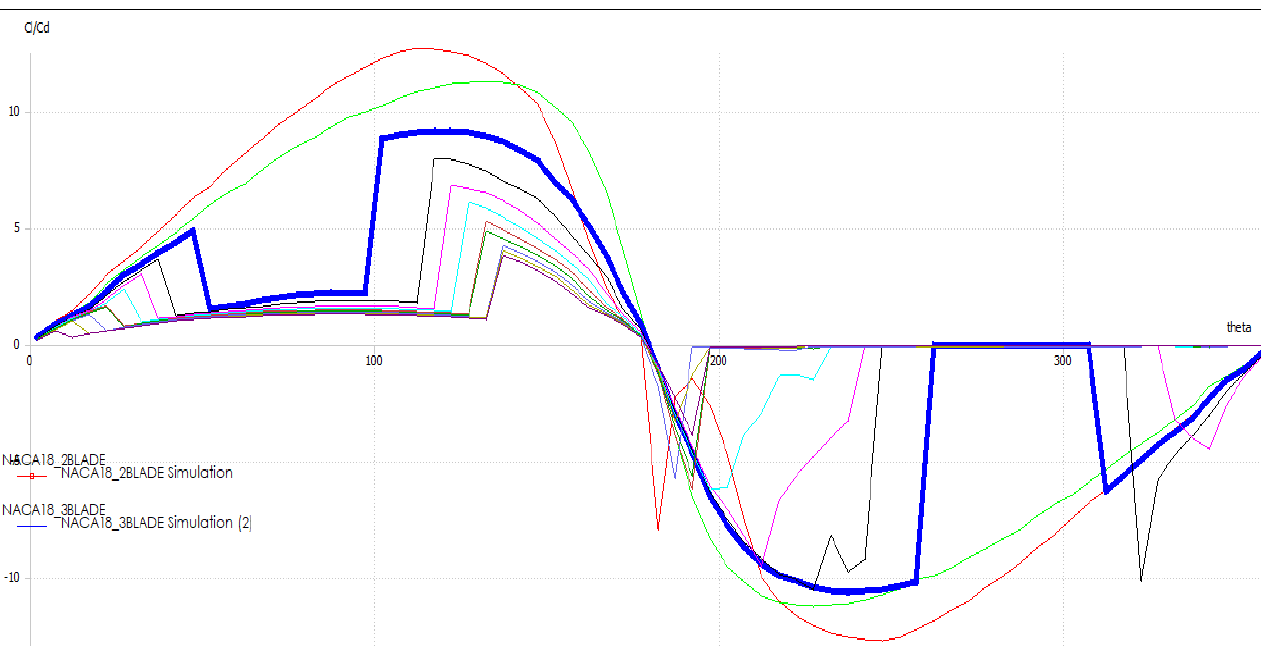
Figure 26. Cl/Cd vs theta plot of top-section for TSR